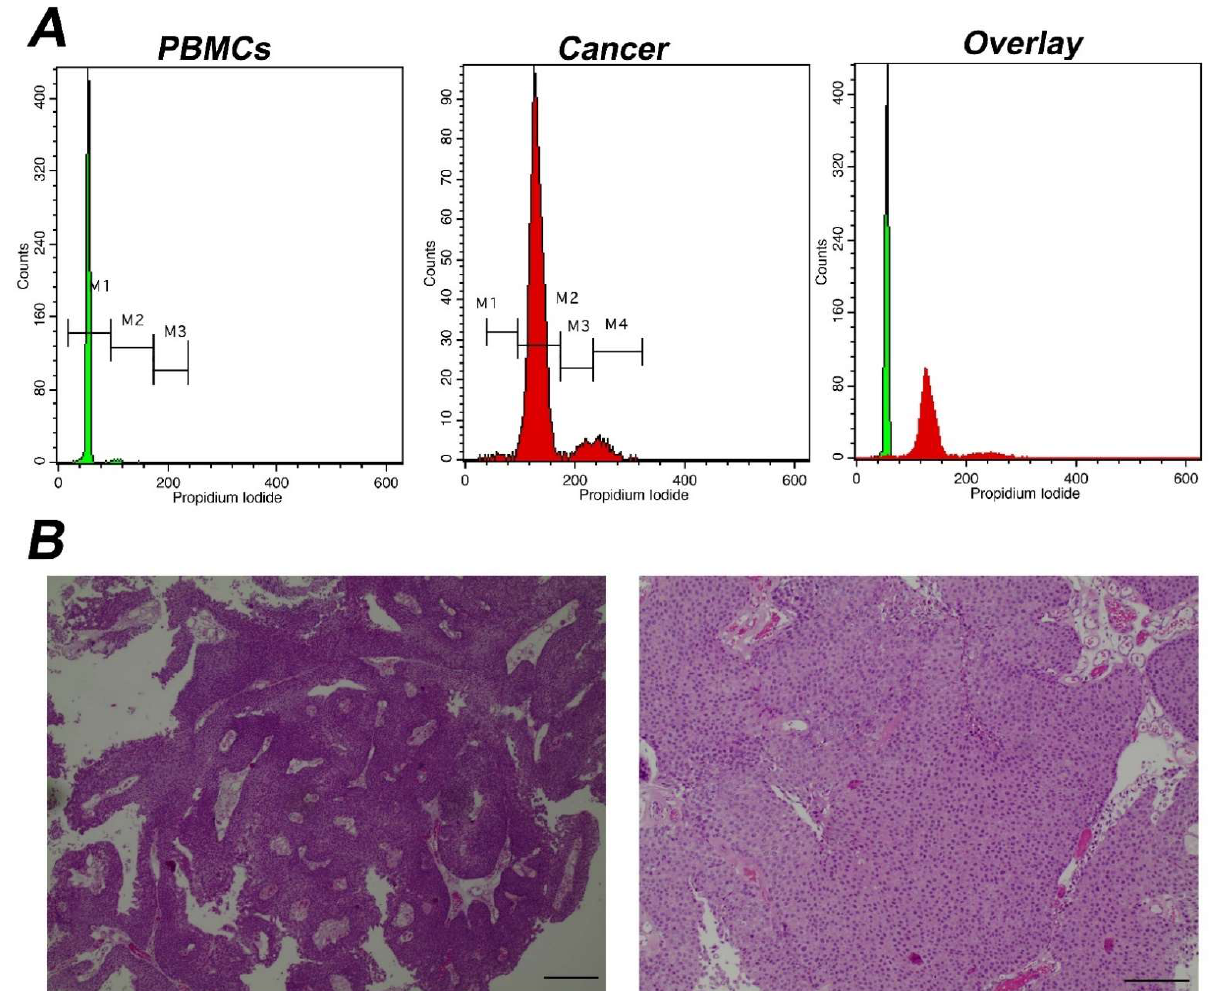
Figure 1. Analysis of a representative aneuploid tumor with high DNA-index ( A ) Analysis using iFC of DNA content and distribution of cell cycle phases. Peripheral blood mononuclear cells/PBMCs ( left panel ) and tumor cells obtained during surgery ( middle panel ) were stained with propidium iodide, to bind nucleic acids. The presented histograms are separated using 3 different marked areas, by respective markers (M1, M2 and M3), in the control PBMC cells. The areas correspond to cells that are in the G1, S, G2/M phases, respectively, based on the mean fluorescence. Cells in G2/M emit a dual mean fluorescence intensity than that of cells in G1, while cells in S phase (DNA replication phase) are characterized by an intermediate fluorescence intensity. In the tumor sample, the G0/G1 peak was coincided with M2 marker due to aneuploidy. Due to that, an additional marker, M4 was introduced and in this case, markers M2, M3 and M4 represent G1, S, G2/M phases, respectively. The DNA-index is 1.7 ( B ) pathology assessment. A papillary urothelial carcinoma of the bladder, low-grade, following hematoxylin-eosin staining. Original magnification × 40 ( left panel ) and × 100 ( right panel ). Scale bars represent 50 um ( left photo ) and 100 um ( right photo ),